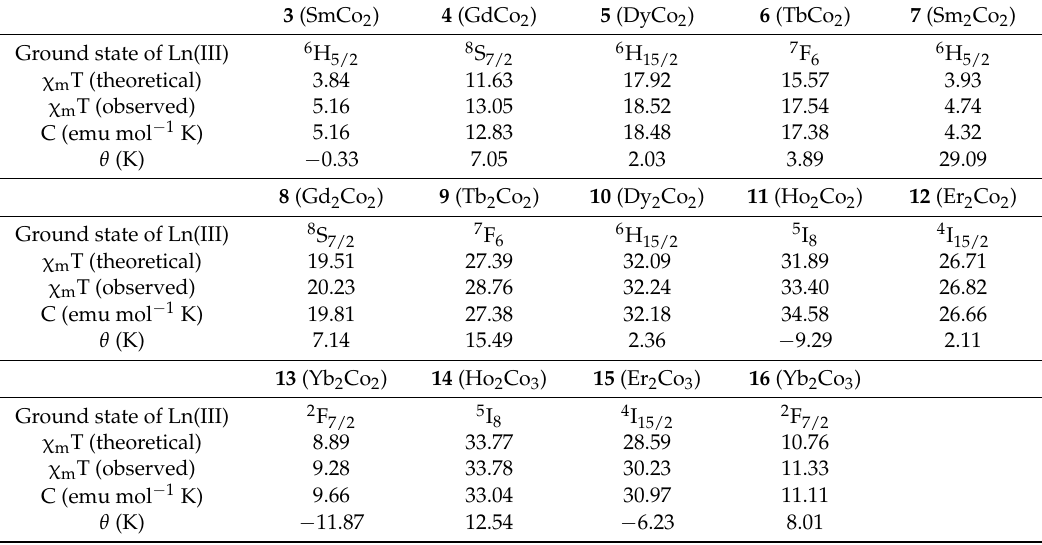
Table 6. Summary of static magnetic properties of the three series of heterometallic compounds 3 – 14 . 3 (SmCo 2